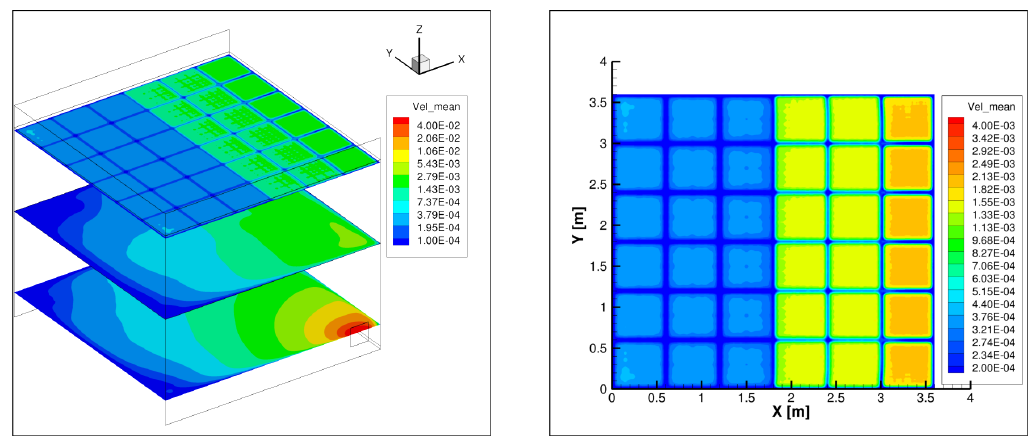
Figure 7. Velocity contour: three horizontal planes (left); the top plane below the ceiling (right) for the continuous distribution in configuration Outlet 1.